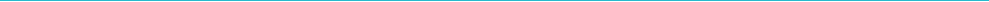
Figure 1: (A) Adjusted survival curves for the PET and standard arms in the Ottawa-FIVE substudy. (B) Adjusted survival curves for the PET and standard arms in the Ottawa-FIVE and the rest of PARR 2. CI = confidence interval; HR = hazard ratio. From: Abraham A, Nichol G, Williams KA, Guo A, deKemp RA, Garrard L, et al.; PARR 2 Investigators. 18F-FDG PET imaging of myocardial viability in an experienced center with access to 18F-FDG and integration with clinical management teams: the Ottawa-FIVE substudy of the PARR 2 trial. J Nucl Med. 2010;51(4):567–74; reprinted with permission of the Society of Nuclear Medicine and Molecular